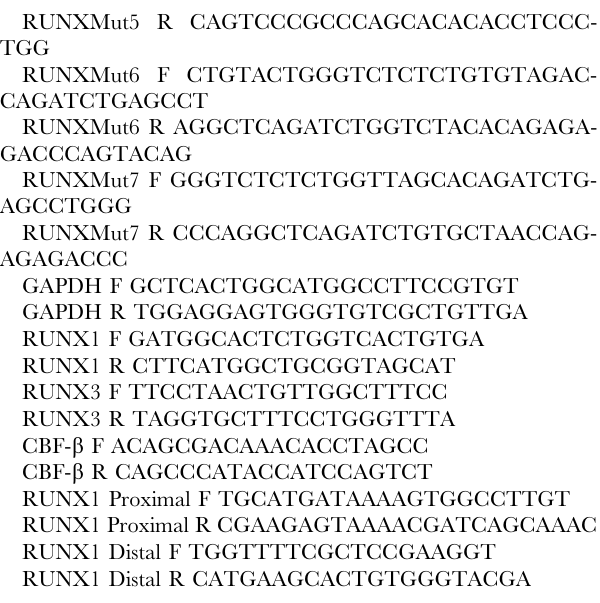
Figure S1 Over-expression of RUNX1 and CBF- b in Jurkat T-cells. Jurkat T-cells were transfected with 1 ug of pMAXGFP or 0.04, 0.2 or 1 ug of pRUNX1 or pCBF- b . Forty- eight hours after transfection the cells were collected, lysed and used for Western blotting to detect RUNX1, CBF- b or b -actin. Figure S2 Knockdown of RUNX1 or CBF- b re-activates virus from latency. ACH2 latently infected T-cell line was transfected with 2, 10 or 50 pMol siRNA against RUNX 1 or CBF- b . A) Supernatant was harvested from ACH2 cell cultures 48 hours post transfection and used to determine viral production by RT assay. RT-qPCR was performed on RNA extracted from the cells at 48 hours to determine the expression levels of B)